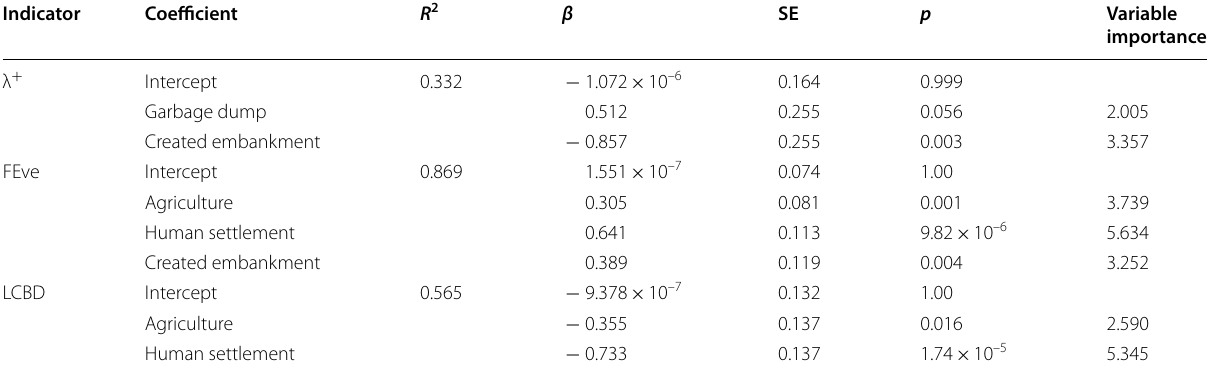
Table 3 Effects of habitat disturbance types (best predictors) on the index of variation in taxonomic distinctness (λ + ), functional evenness (FEve), and local contribution to β diversity (LCBD) of the spider community of the 27 sites studied along the Ganga River, India Indicator